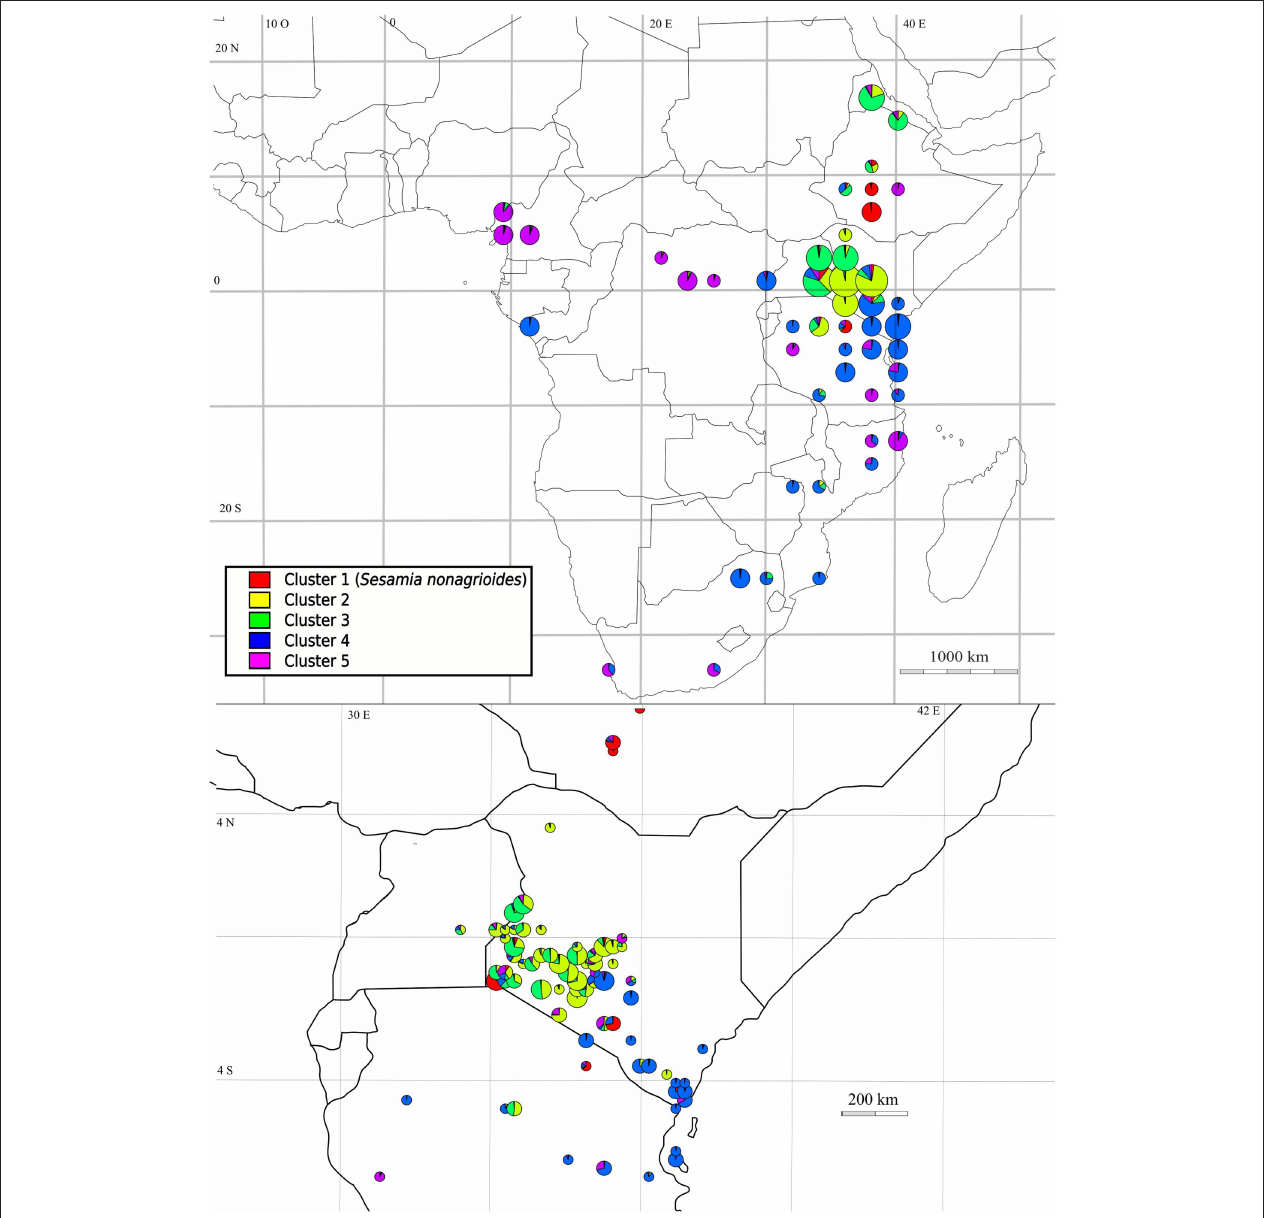
FIGURE 2 | Distribution of genetic clusters of Cotesia sesamiae wasps for the Instruct software CLUMPP consensus with K = 5. Only individuals with a maximum posterior probability of assignment above 0.5 are represented. Distribution in Sub-Saharan Africa is represented at the top and a zoom in Kenya at the bottom.